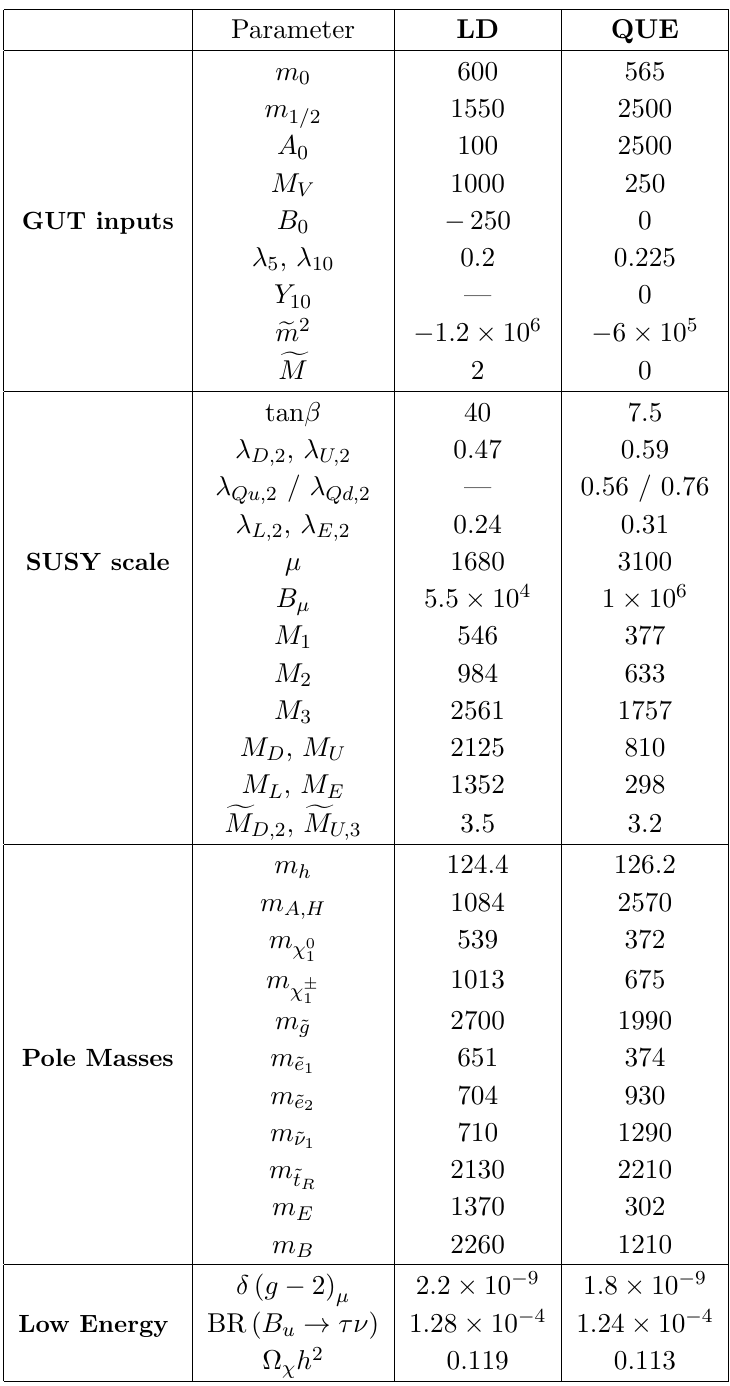
Table 2. Benchmark points for the models LD and QUE . Dimensionful quantities are given in GeV and GeV 2 , and (cid:15) = (cid:11) =